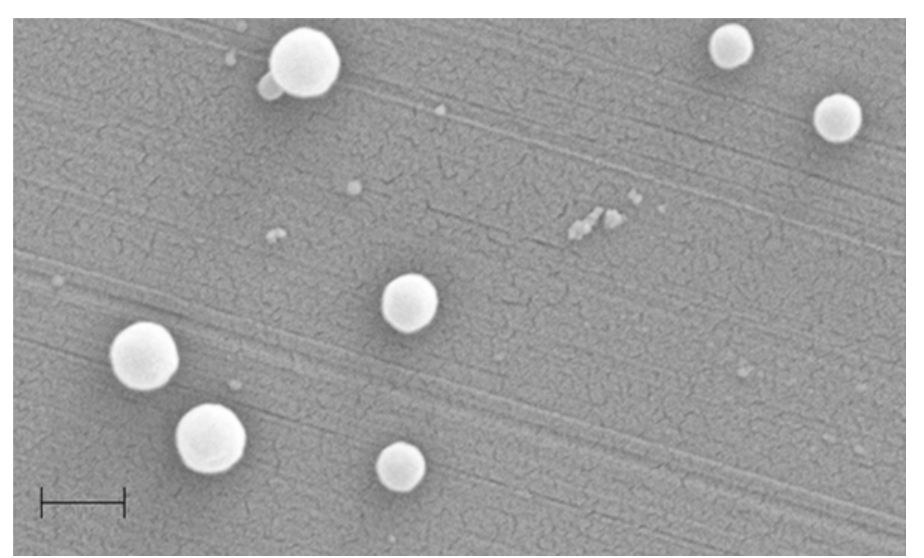
Figure 38. Scanning electron miroscopy image of L -RA-Pro-based SLNs spread on a glass surface (scale bar 200 nm)